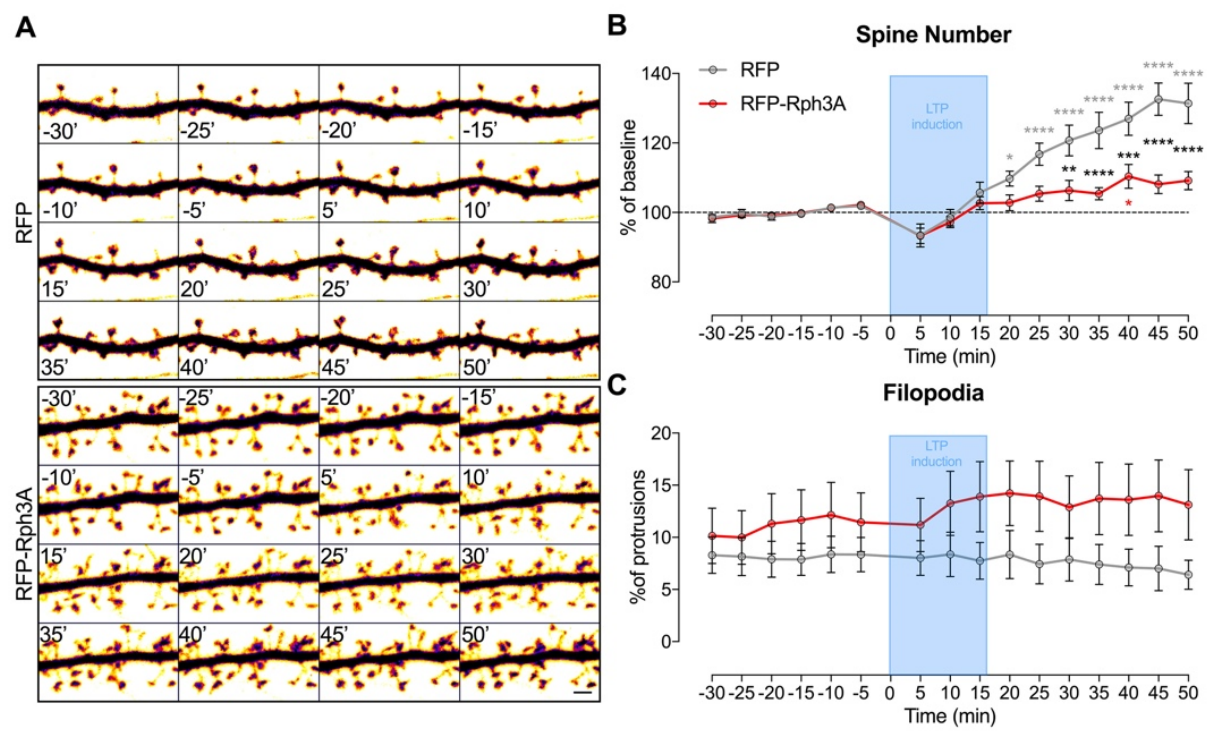
Figure 7. Rph3A overexpression and cLTP in live-imaging of dendritic spines. ( A ): Confocal time lapse images of GFP filler in dendritic spines of RFP ( up ) or RFP-Rph3A ( down ) transfected neu- rons. Scale bar: 2 µm. ( B ): XY graph representing mean ± SEM spine number as a percentage of T 0 (0 min) in RFP (grey) or RFP-Rph3A (red) transfected neurons over time before and after cLTP. ( C ): XY graph representing mean ± SEM filopodia as a percentage of total protrusions in RFP (grey) or RFP-Rph3A (red) transfected neurons over time. Repeated measures two-way ANOVA with Dun- nett’s multiple comparison test ( − 15 min vs. all other time points) or Sidak’s multiple comparison test (RFP vs. RFP-Rph3A). * p < 0.05, ** p < 0.01, *** p < 0.001, **** p < 0.0001.